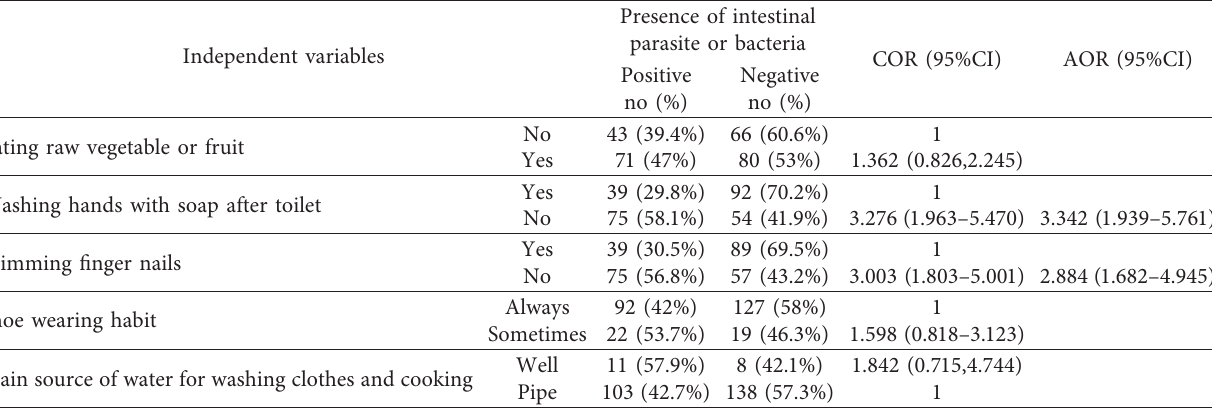
Table 2: Binary logistic regression for factors associated with intestinal parasites or enteric bacterial infections among street food handlers in Jimma town, Southwest Ethiopia ( n � 260), Oct–Dec 2020.